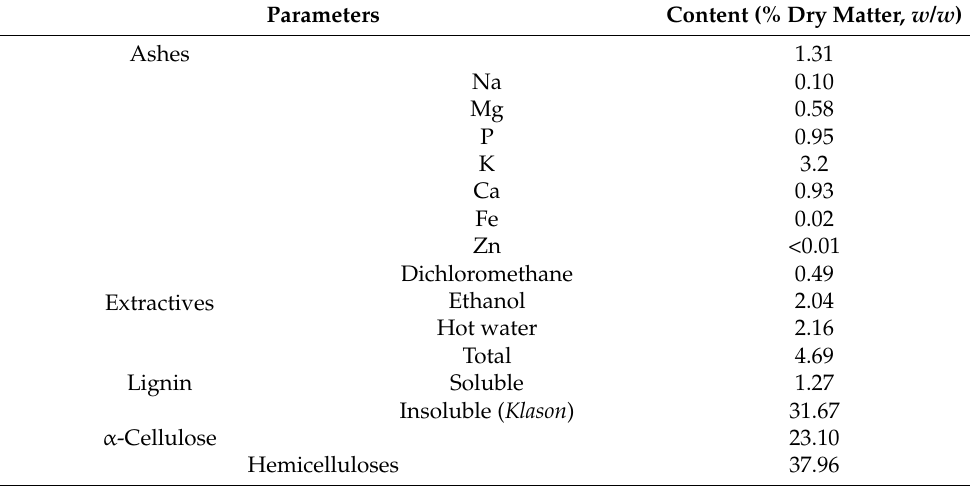
Table 1. Chemical composition of